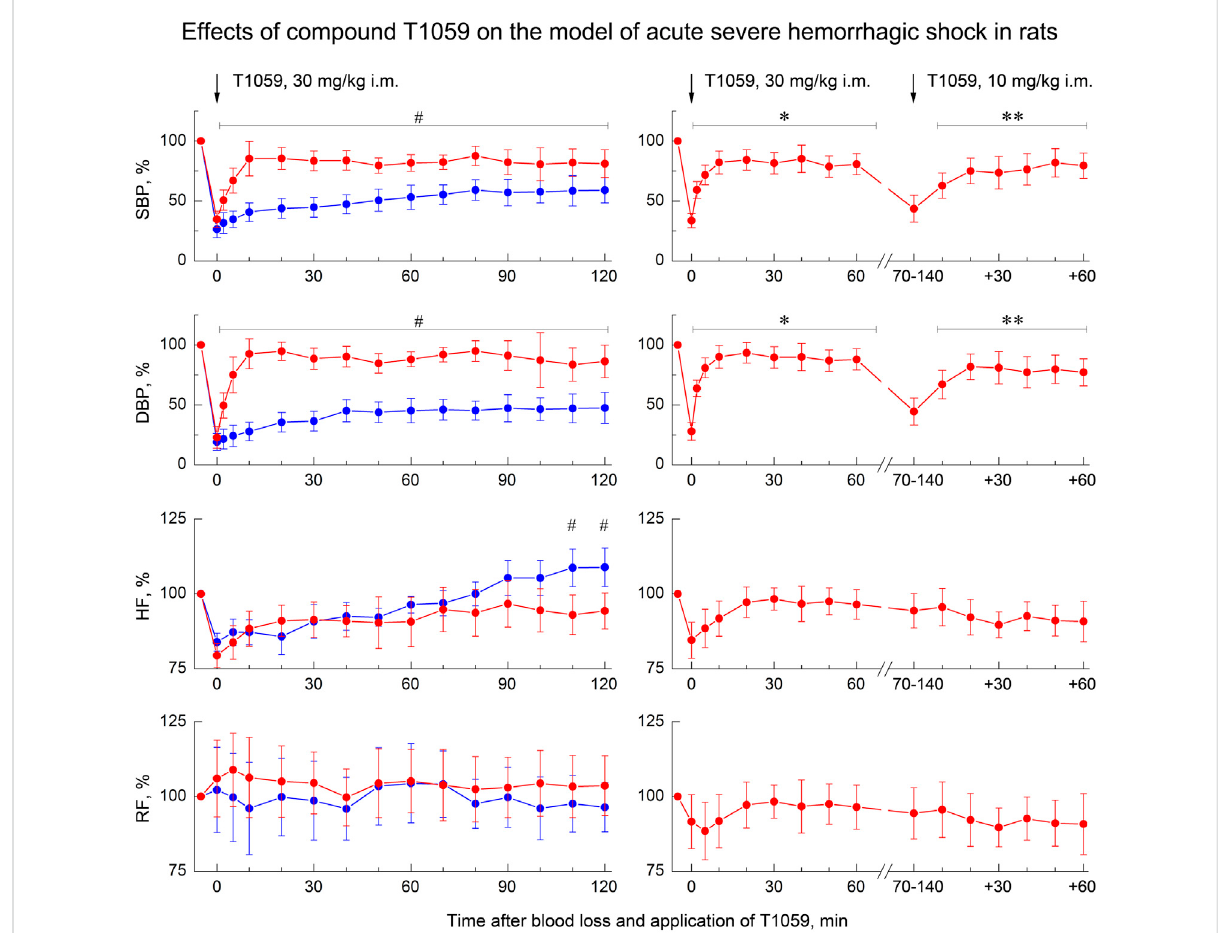
FIGURE 4 Effect of compound T1059 with a single i.m. injection at dose of 30 mg/kg (left) and two times i.m. injection at doses 30 + 10 mg/kg (right) on hemodynamics and external respiration of Wistar rats at an early stage of acute severe hemorrhagic shock. Red symbols and lines are indicators of T1059-treated rats ( n = 12 – 16 per point), blue symbols and lines are indicators of untreated rats ( n = 10 – 28). Data are normalized to the original values of indicators of animals and presented as percentage. Graphical deviations correspond to SD. # - signi fi cantly different indicators in untreated vs.T1059-treatedrats(SBP: p =0.04754, p =0.01182, p =0.00736, p =0.00598, p =0.00721, p = 0.00907, p =0.00984, p =0.01070, p = 0.00833, p = 0.00645, p =0.02651, p = 0.03076, p = 0.04182, p = 0.03287, respectively; DBP: p = 0.02744, p =0.00056, p =0.00003, p < 0.00001, p = 0.00012, p = 0.00290, p = 0.00437, p = 0.00305, p = 0.00184, p = 0.00076, p = 0.00742, p = 0,01539, p = 0.01163, p = 0.00906, respectively; HF: p = 0.02747, p = 0.03825, respectively). *- signi fi cantly different with the indicator immediately after blood loss (SBP: p = 0.00817, p =